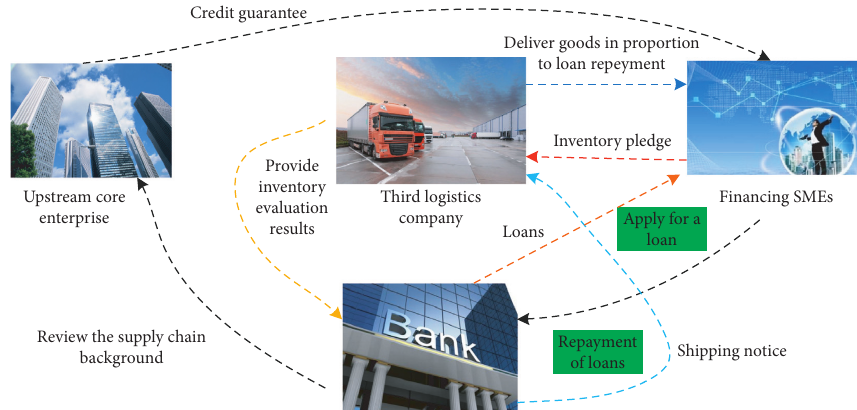
Figure 3: Inventory pledge financing business